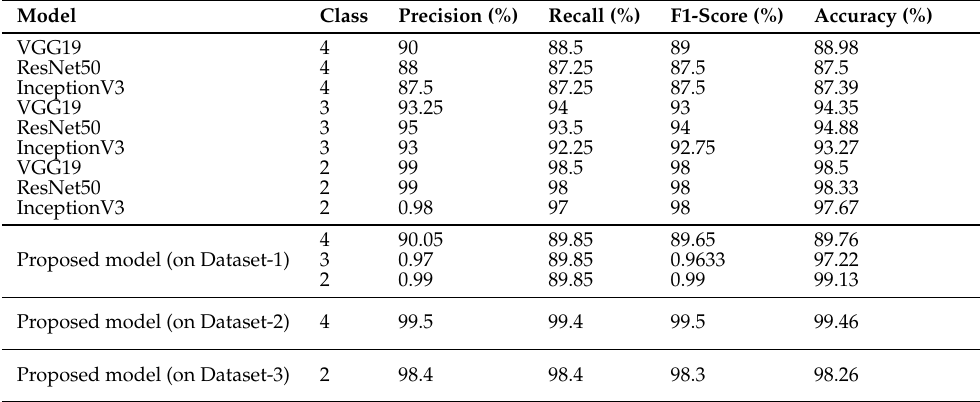
Table 11. Performance results comparison among the suggested model and the other traditional pre-trained